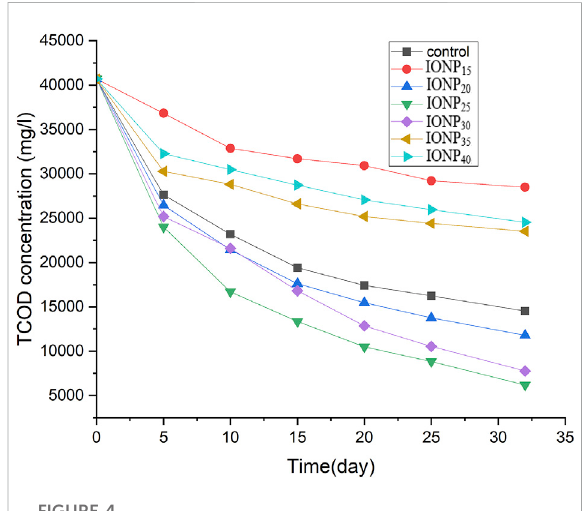
FIGURE 4 EffectofdifferentIONPdosesontheconcentrationofTCOD.